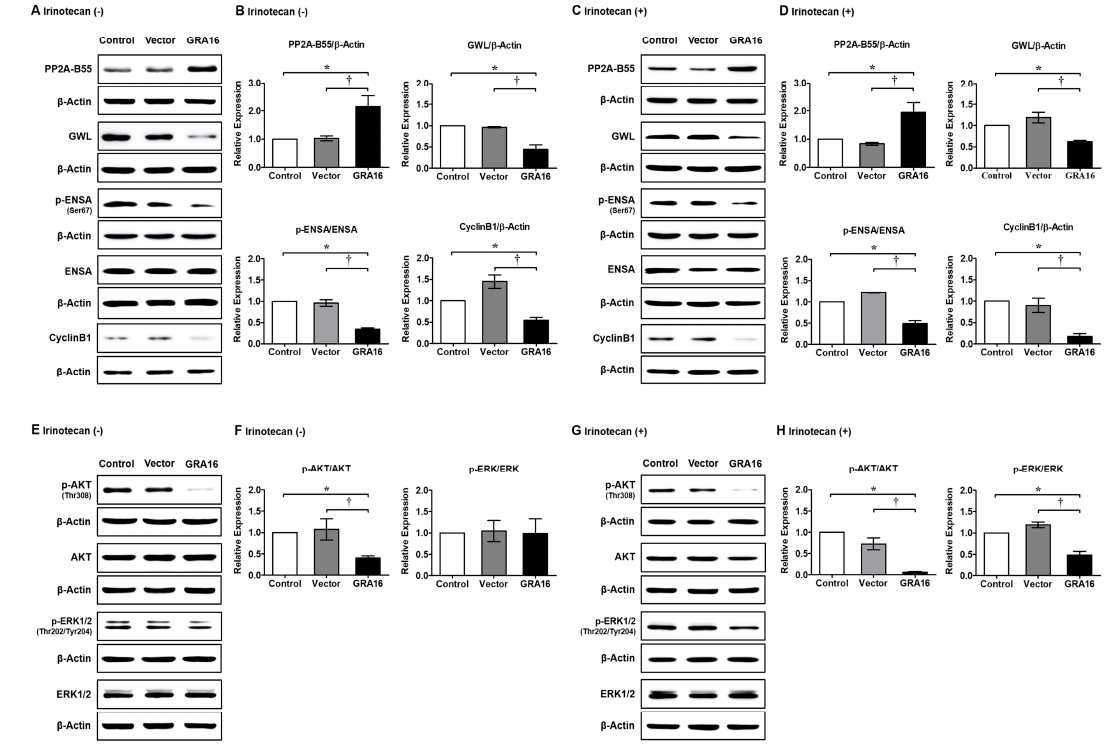
Figure 3. Inhibition in GWL and ENSA phosphorylation and cyclin B1 level and dephosphorylation of AKT and ERK by the augmentation of PP2A-B55 in GRA16 cells. ( A ) Western blots of PP2A-B55, GWL, p-ENSA, and cyclin B1 expression in cells without irinotecan treatment. ( B ) Relative expression levels of these proteins in vector and GRA16 cells compared with control cells. ( C ) Expression levels of each protein under irinotecan treatment compared with those in ( A ). ( D ) Relative expression levels of these proteins under irinotecan treatment compared with those in ( B ). ( E ) Western blots of p-AKT and p-ERK expression without irinotecan treatment. ( F ) Ratios of p-AKT / AKT and p-ERK / ERK expression without irinotecan treatment. ( G ) Western blots of p-AKT and p-ERK expression under irinotecan treatment. ( H ) Ratios of p-AKT / AKT and p-ERK / ERK expression under irinotecan treatment. * significant at p < 0.05 between control and GRA16 cells; † significant at p < 0.05 between vector and GRA16 cells. 2.5. NF- κ B Inhibition in NSCLC Cells in the Presence of GRA16 and / or